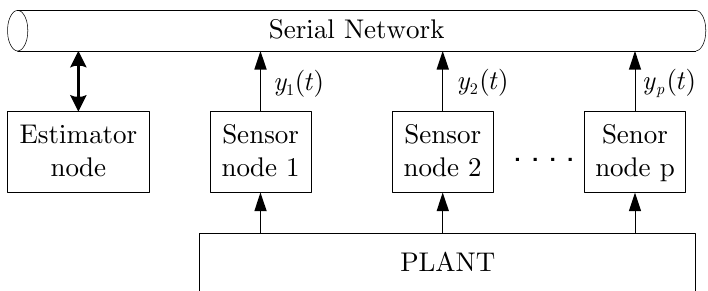
Figure 1. Configuration of a networked control system Estimator node